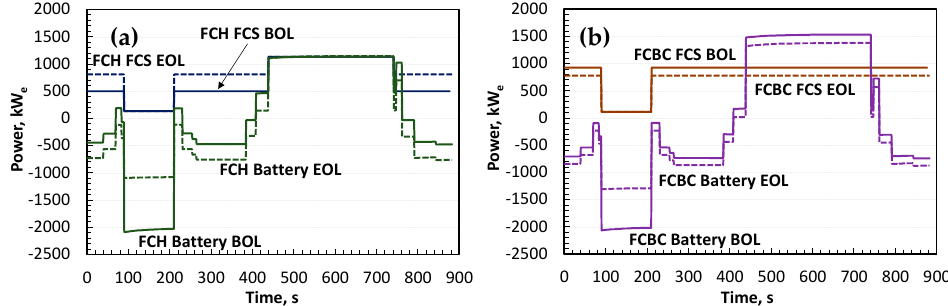
Figure 7. Power sharing between FCS and battery during a mining truck duty cycle at extreme conditions: BOL vs. EOL and 50 °C vs. 25 °C ambient temperatures: ( a ) FCH platform; ( b ) FCBC platform.